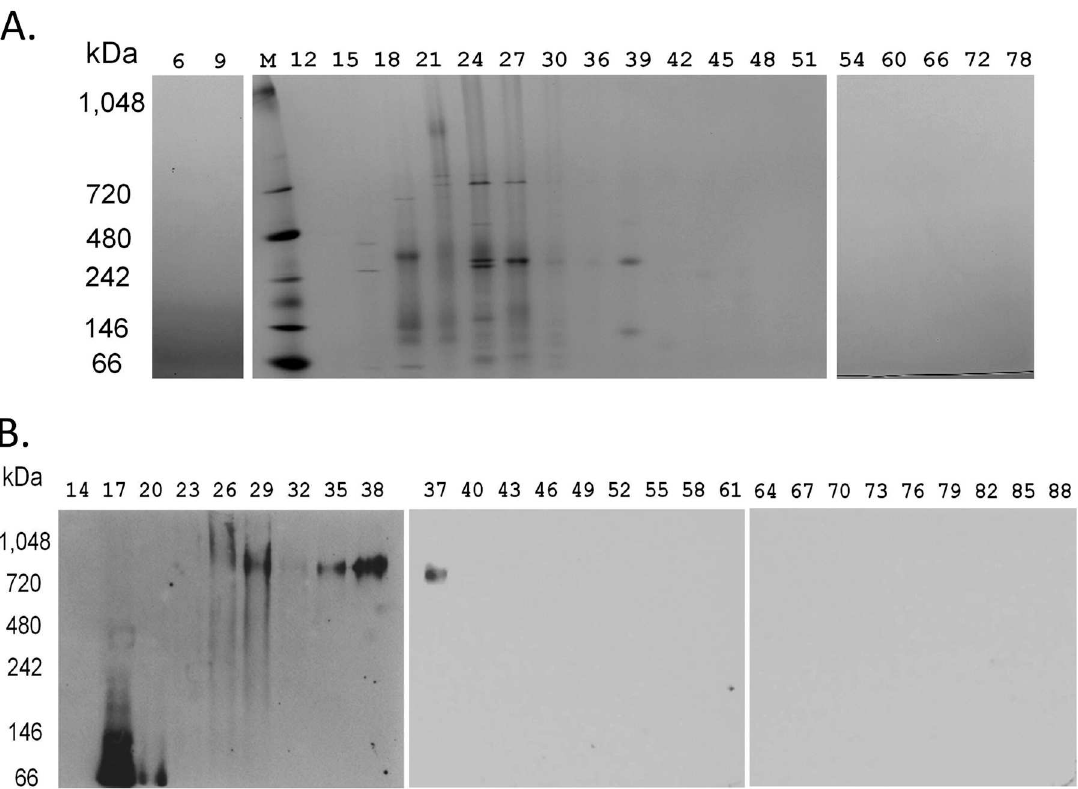
Fig 3. Separation of IZE fractions by BN gel electrophoresis. (A) The gels were stainedwith Coomassie. (B) Separategels were transferred to PVDF membraneand probedwith PCNA antibody.Fraction numbers are labeledon top of the figure.